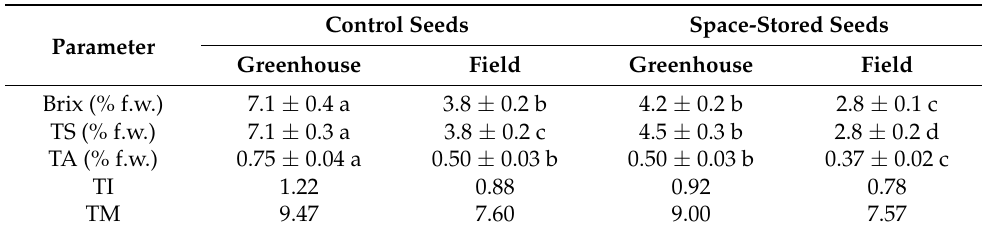
Table 4. Monosaccharide and organic acid contents, and taste index (TI) of tomato fruits obtained from control and spaceflight-exposed seeds, in greenhouse and in open field.